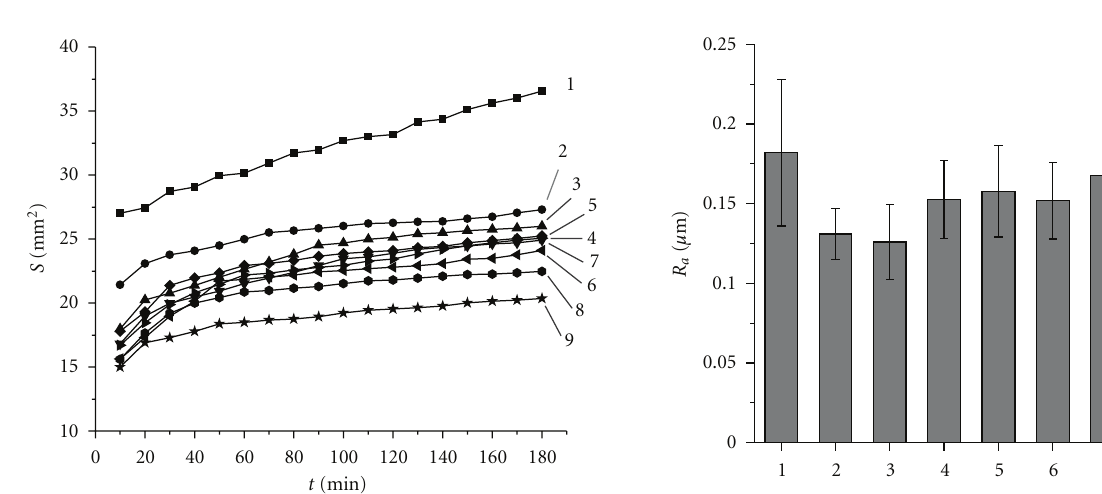
Figure 3: Dependence of surface roughness of wear track (Ra) in pure UHMWPE (1), nanocomposites UHMWPE +0.1 (2), 0.5 (3), 1 (4), 2(5)wt.% HA and microcomposites UHMWPE +5 (6), 10